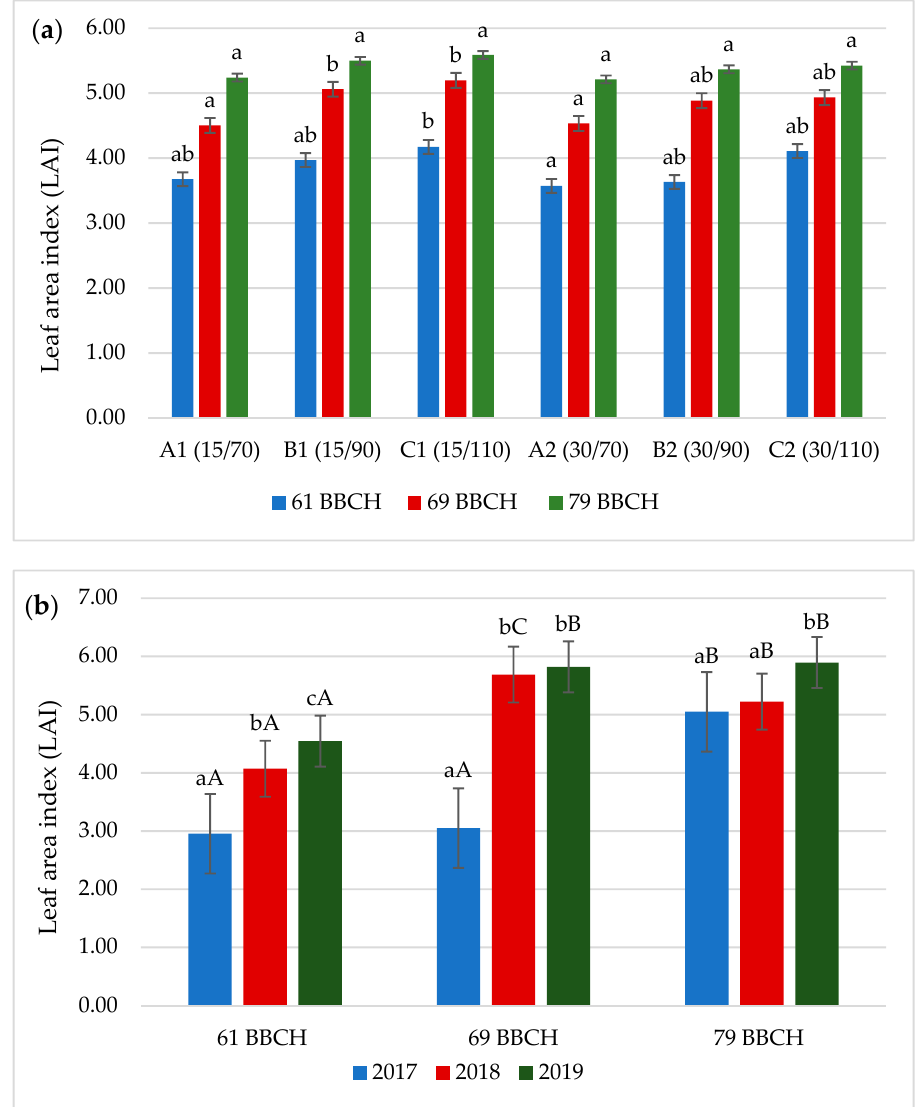
Figure 6. Effect of row spacing and sowing density on Leaf Area Index (LAI) of soybean ( a ) between variants of the experiment during the 3-years study ( b ) between years of research. Lowercase letters indicate significant differences between the means in the measurement phases, capital letters indicate significant differences between means in the years of research according to ANOVA (followed by Tukey’s HSD test, p = 0.05).